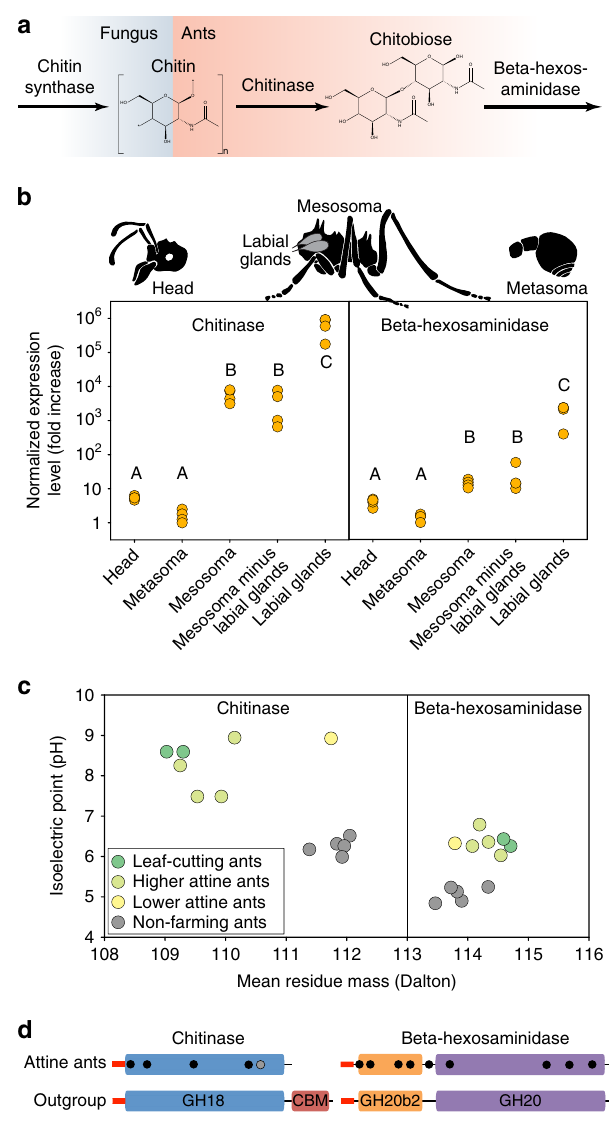
Figure 4 | Coevolutionary changes in chitin-related functions in attine ants and their cultivars. ( a ) Two genes encoding chitinase and b -hexosaminidase enzymes show signatures of positive selection in the attine ancestor, whereas three chitin-synthase genes are positively selected in the ancestor of the higher attine cultivars. ( b ) Expression of the same genes in worker tissues showing very high expression in labial glands situated in the prothorax. Shared letters indicate that tissues do not differ significantly in gene expression level ( n ¼ 4, Tukey’s honest significant difference, P 4 0.05). High expression in the mesosoma minus labial glands might reflect expression in additional tissues with contributions from residual fragments of the labial glands. ( c ) The positively selected attine ant ( n ¼ 7) chitinase and b -hexosaminidase proteins have significantly higher isoelectric points than the orthologous proteins in other myrmicine ants ( n ¼ 5, phylogenetic ANOVA, both P o 0.03). ( d ) The conserved catalytic chitinase domain (GH18) of attine ants with its lost C-terminal chitin- binding domain (CBM) and dots indicating the positions of four amino acid residues that experienced positive selection in the ancestor of all attine ants (black) or in the ancestor of the higher attines only (grey). In contrast, the full b -hexosaminidase domain architecture is intact with both GH20 and GH20b2 domains, and nine sites positively selected in the ancestor of all attine ants (black